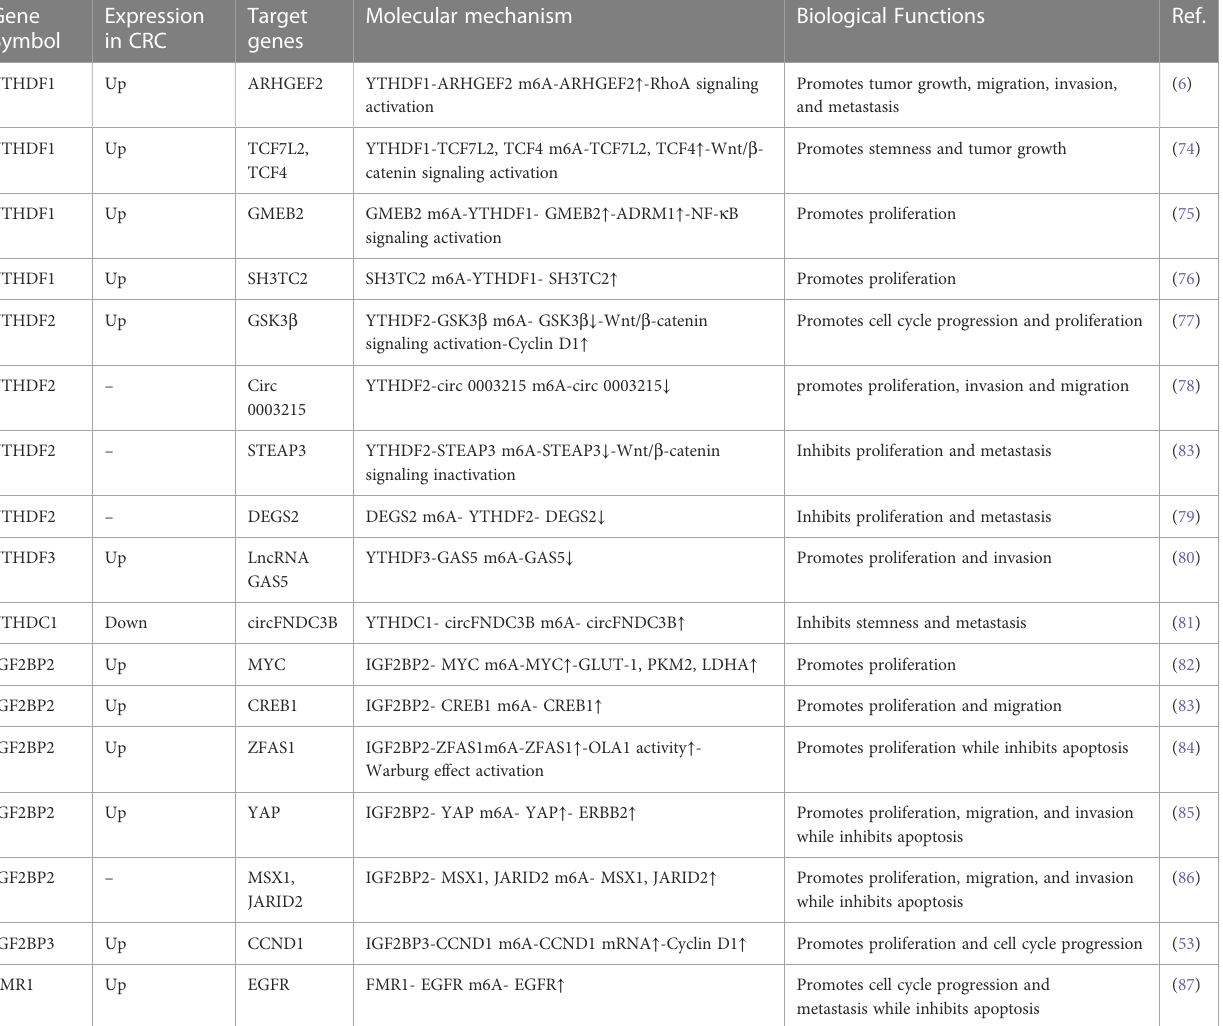
TABLE 3 Functions of m6A “ readers ” in